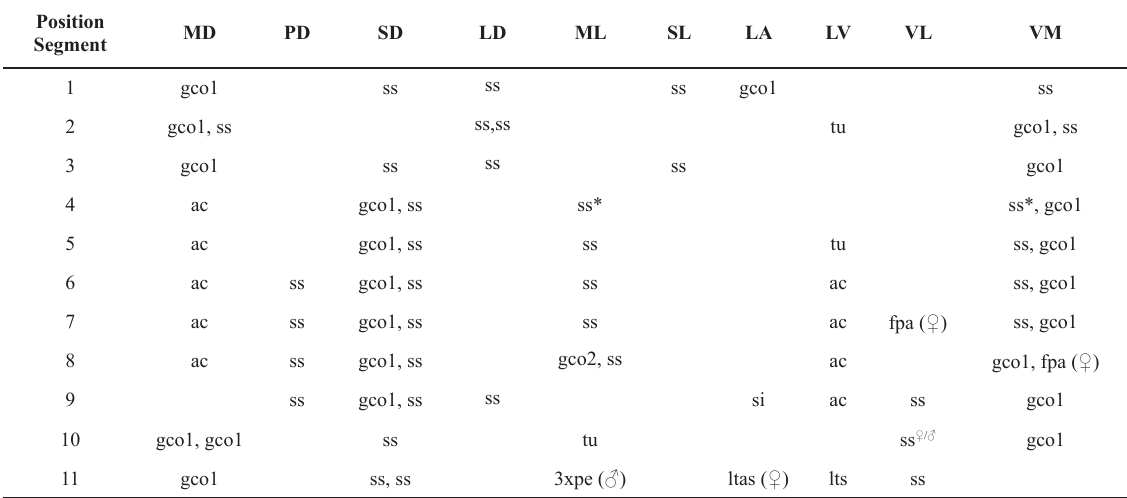
Table 16. Summary of nature and location of sensory spots, glandular cell outlets, tubes and spines arranged by series in Echinoderes songae Sørensen & Chang sp.